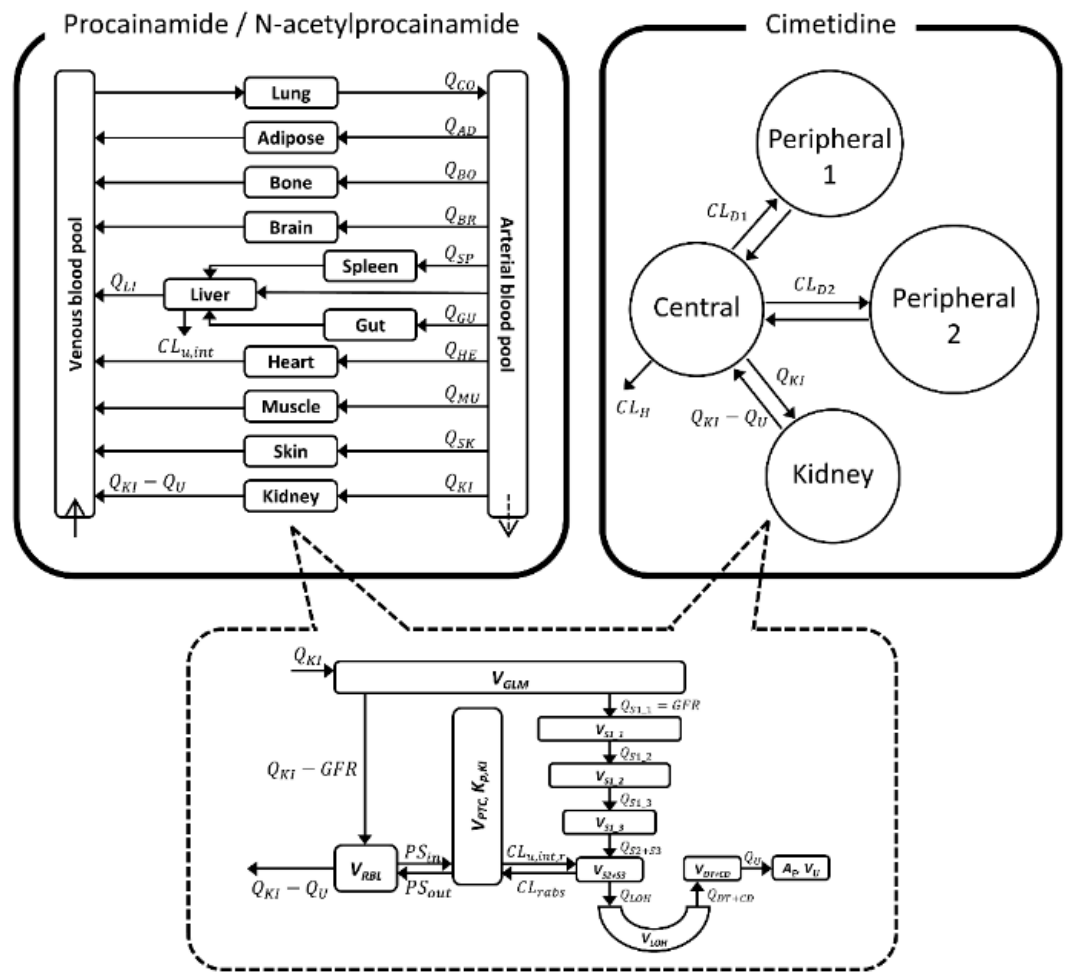
Figure 1. Structure of the whole-body physiologically-based pharmacokinetic (PBPK) model used to describe the pharmacokinetics of procainamide (PA) and N -acetylprocainamide (NAPA) (left upper), and of the minimal PBPK model used for cimetidine (right upper), were incorporated into the final PBPK model with a semi-mechanistic kidney model (lower).